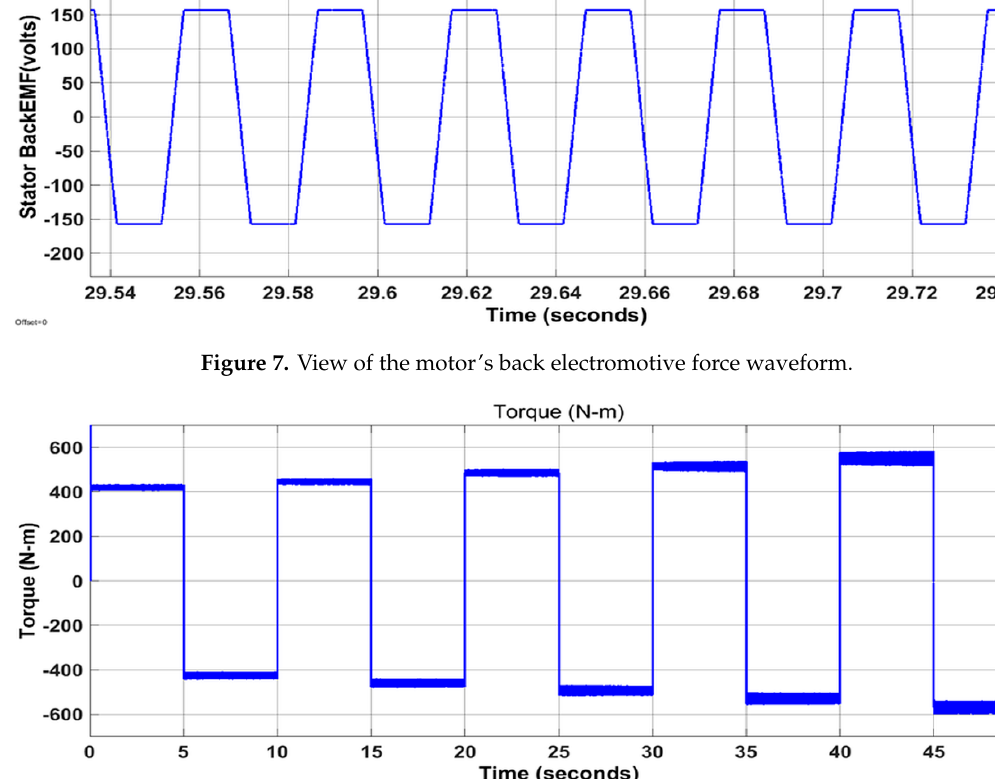
Figure 7. View of the motor’s back electromotive force waveform.